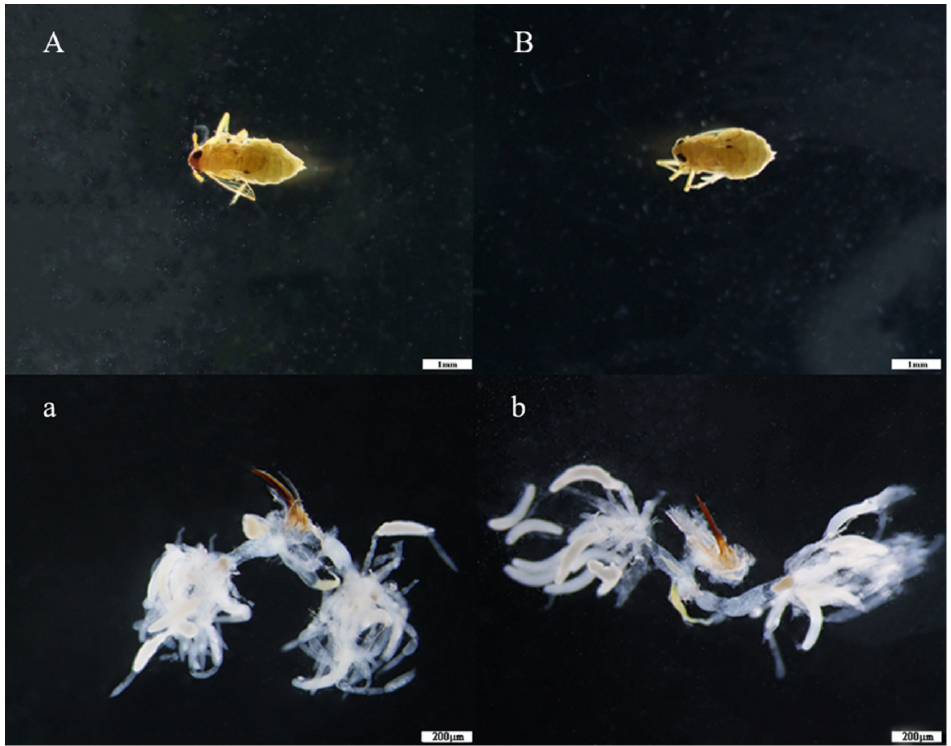
Figure 3. Morphology and ovary development in BPH fed on drought-stressed and non-stressed (control) rice. Panels ( A , a ) show morphology and ovary development in BPH feeding on non-stressed, control rice. Panels ( B , b ) show morphology and ovary development in BPH feeding on drought-stressed rice. ( A , B ) Body size was photographed with a Leica DMR connected to a Fuji FinePix S2 Pro digital camera (Wetzlar, Hesse-Darmstadt, Germany). Scale bar, 1 mm. ( a , b ) reproductive tracts from mated females; scale bar, 200 μ m. Body size and ovaries from at least ten females were dissected and observed for each group.